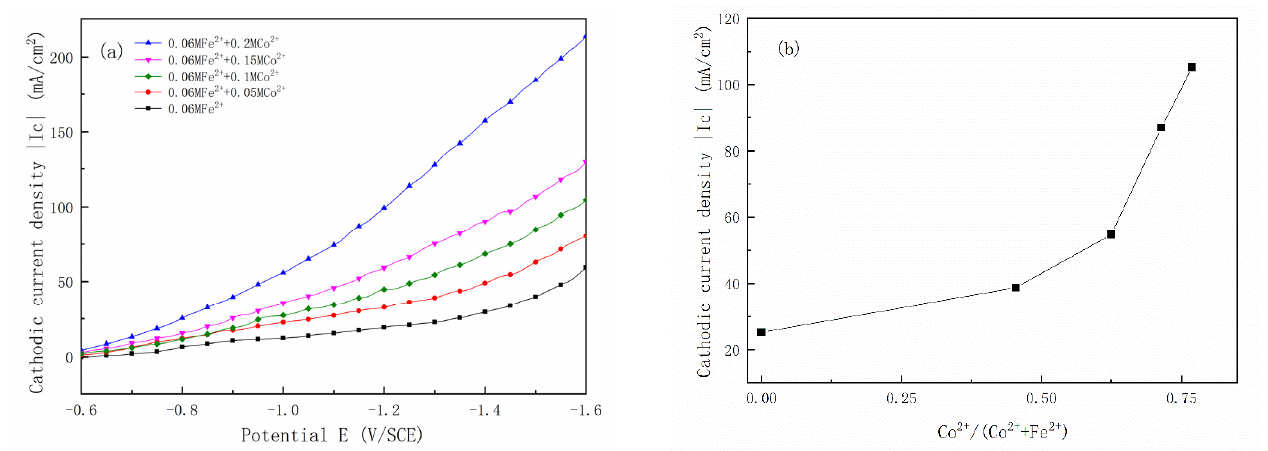
Figure 7. ( a ) Cathodic polarization curves measured in solutions with different Co 2+ concentrations; ( b ) the corresponding cathodic current density |Ic| at a potential of − 1.2 V.